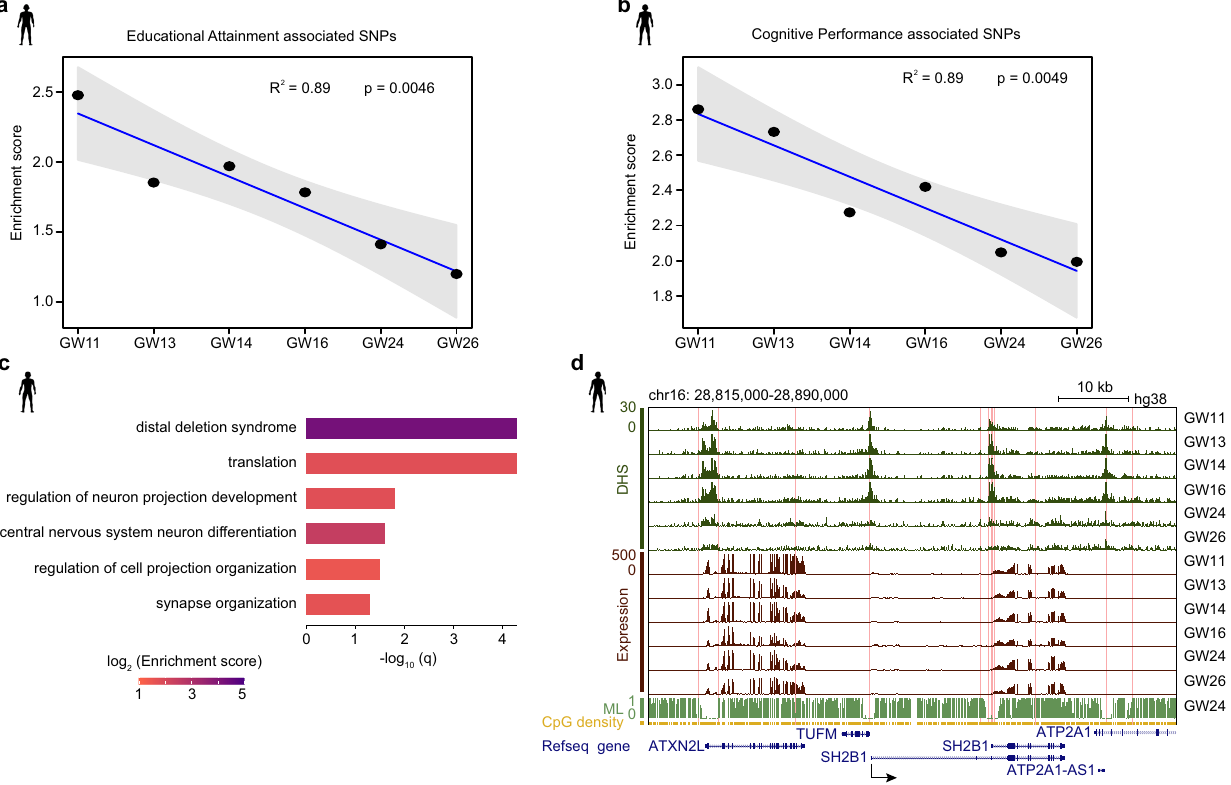
Fig. 6 The relationship between human cognitive performance and chromatin accessibility during PFC development. a Enrichment of educational attainment associated SNPs ( n = 2191) in DHS regions in human PFCs exhibits a decreasing trend during development. Gray shading indicates 95% con fi dence intervals. b Enrichment of cognitive performance associated SNPs ( n = 323) in DHS regions in human PFCs exhibits a decreasing trend during development. Gray shading indicates 95% con fi dence intervals. c GO analyses for educational attainment and cognitive performance SNP associated genes. P values are calculated based on the accumulative hypergeometric distribution and q-values are the multiple test adjusted p values and multiple testing is performed with the Banjamini-Hochberg method. d Genome browser view of the DHS signal near SH2B1 and RNA expression of SH2B1 . Pink shadows mark the locations of SNPs which are associated with educational attainment and cognitive